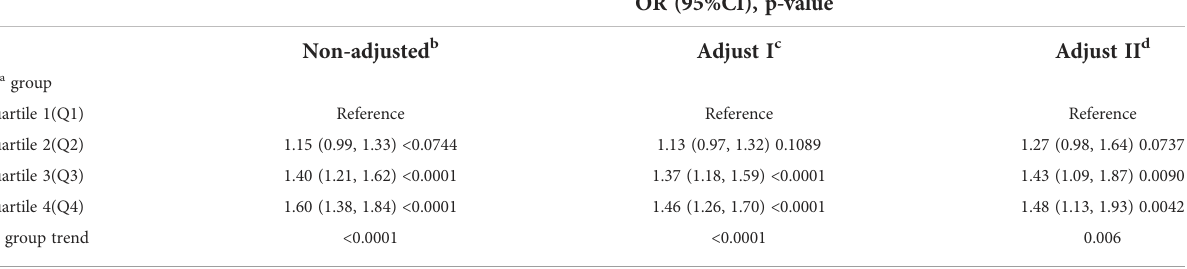
TABLE 2 Logistic regression analysis was used to assess the correlation between the prevalence of testosterone de fi ciency and SII.